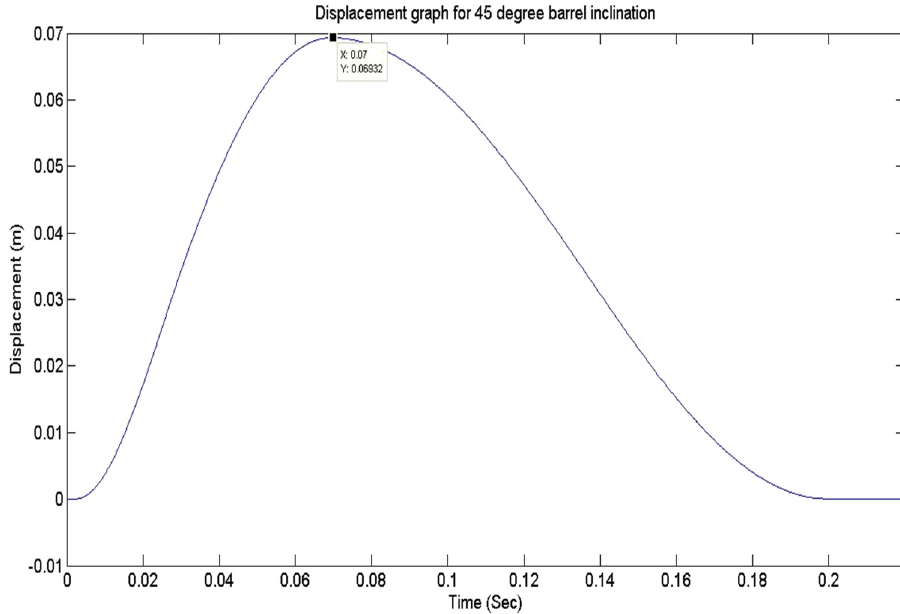
Figure 6: Displacement vs time at 45° fi ring